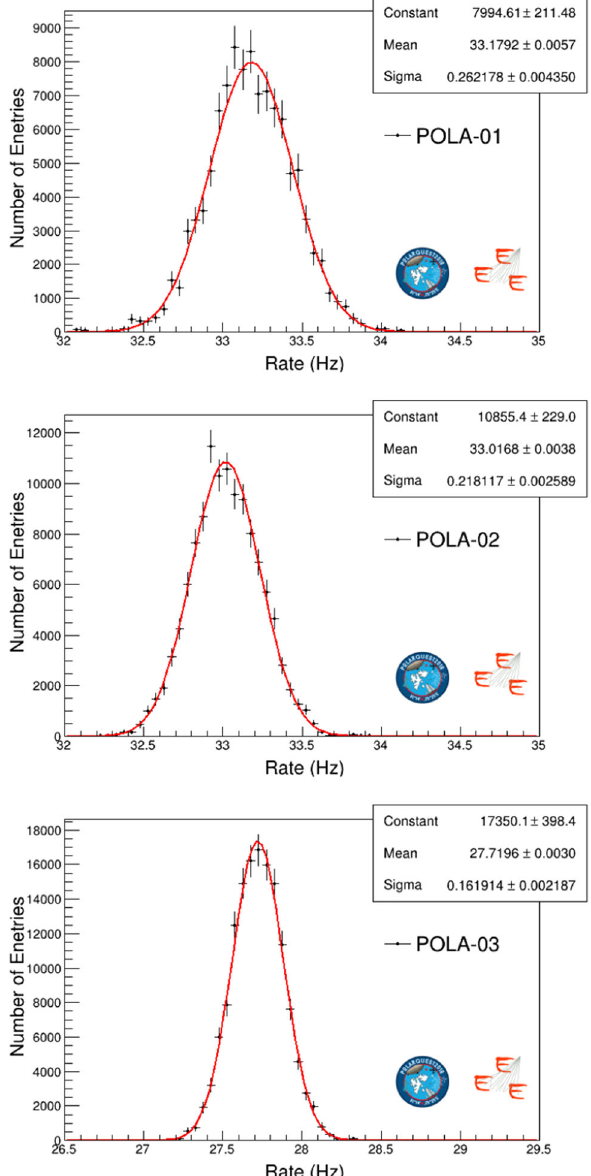
Fig. 24 Distributions of the rate observed by the three POLA detectors during data taking, with Gaussian fits